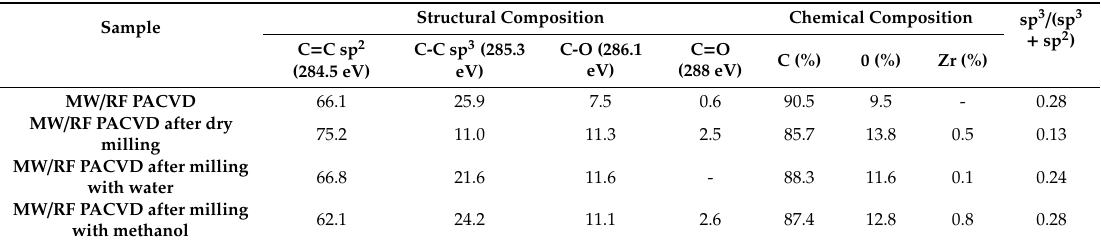
Figure 5. Raman spectra of powders: ( a ) produced using the CVD method; ( b ) dry-milled; ( c ) milled water; ( d ) milled in methanol. in water; ( d ) milled in methanol. Table 4. Analysis of Raman spectra of powders produced using the CVD method, dry-milled, milled Table 5. Analysis of chemical and phase composition of powders produced using the CVD method, in water, milled in methanol. dry-milled, milled in water, milled in